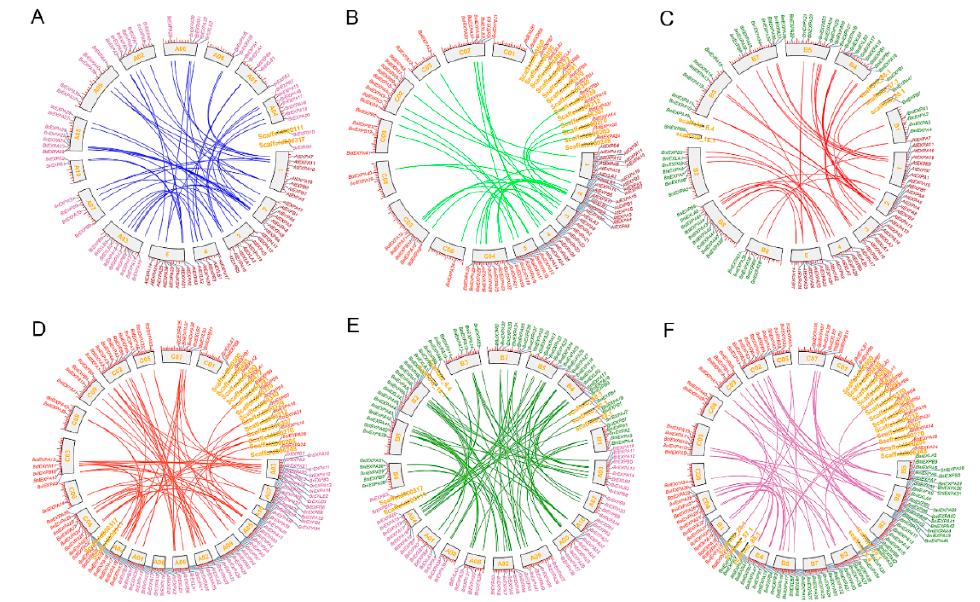
Figure 5. The syntenic analyses and positions on corresponding genomes of expansin genes in the four species. ( A – C ) The orthologous gene pairs between A. thaliana and B. rapa ( A ), A. thaliana and B. oleracea ( B ), and A. thaliana and B. nigra ( C ) . ( D , E ) The homologous gene pairs between B. rapa and B. oleracea ( D ), and B. rapa and B. nigra ( E ). ( F ) The homologous gene pairs between B. oleracea and B. nigra.